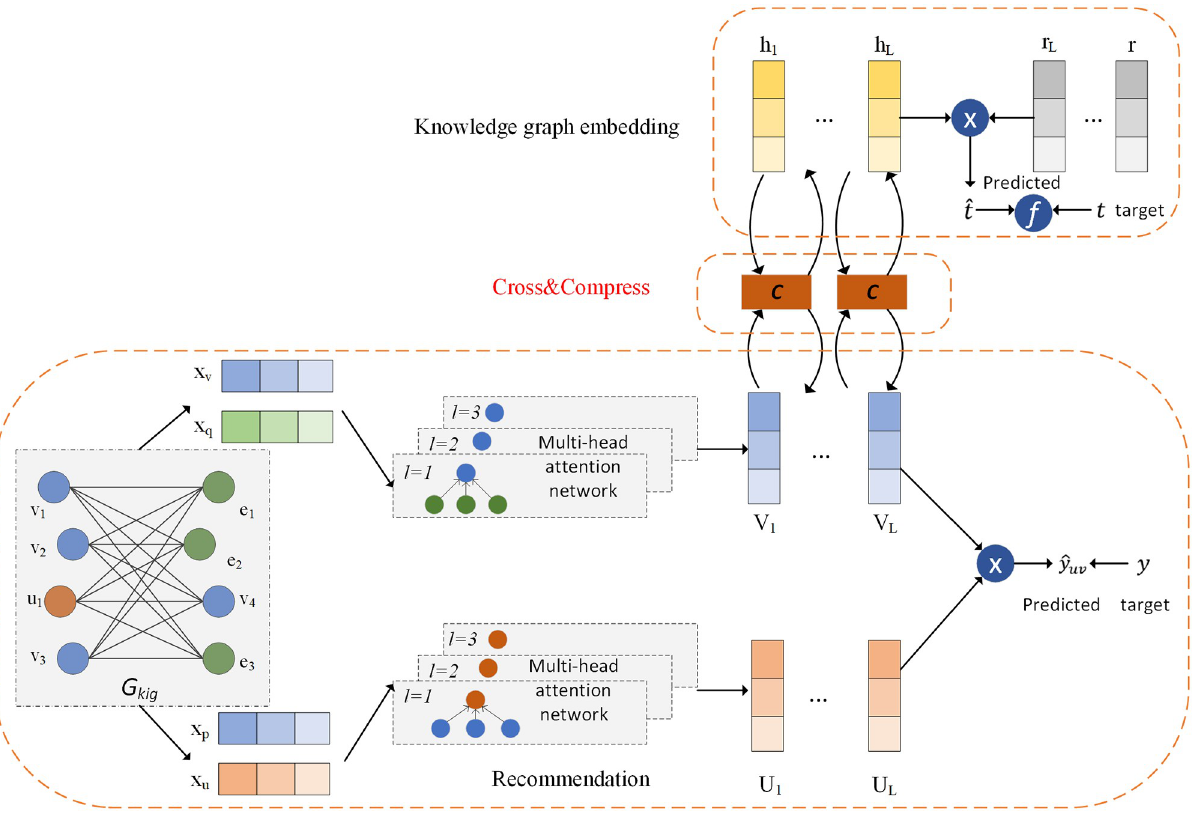
Fig 2. The framework of MNI. The bottom part is the recommendation module where the knowledge-enhanced interaction model (KIG) is constructed, and high-order neighborhood is integrated by multi-head attention network. The middle part is the cross&compress unit, a bridge for exchanging latent features. The upper part shows the knowledge graph embedding that predicting the target tail entity by head and relation embedding.